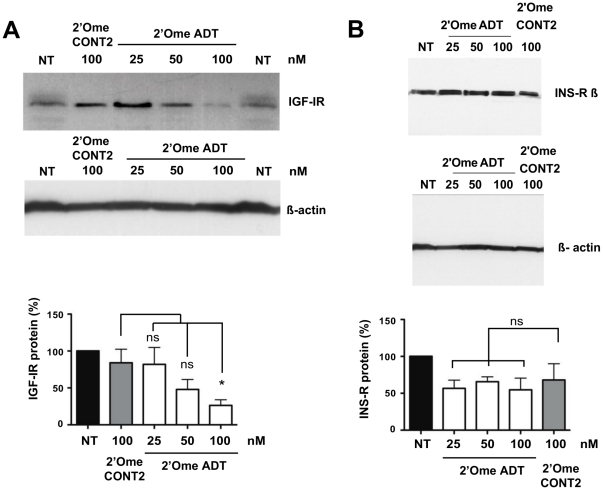
2′-O-methyl siRNAs targeted to IGF-IR.(A), Western blot analysis of IGF-IR after 48 h transfection of EMT6 cells with 2′-O-methyl siRNAs. NT and black bars are non-transfected cells. Western blot example and quantitative analysis of five independent experiments are shown with means ± SEM. * P<0.05; ns, not significant. (B), Western blot analysis of INS-R proteins isolated from EMT6 cells 48 h after transfection with 2′-O-methyl uridine containing anti IGF-IR siRNAs at 25, 50 or 100 nM. Black bars represent mock transfected cells (NT). A representative experiment is presented with quantitative analysis of four independent experiments (means ± SEM; ns, not significant). Differences between NT and siRNA treated samples were not statistically significant.